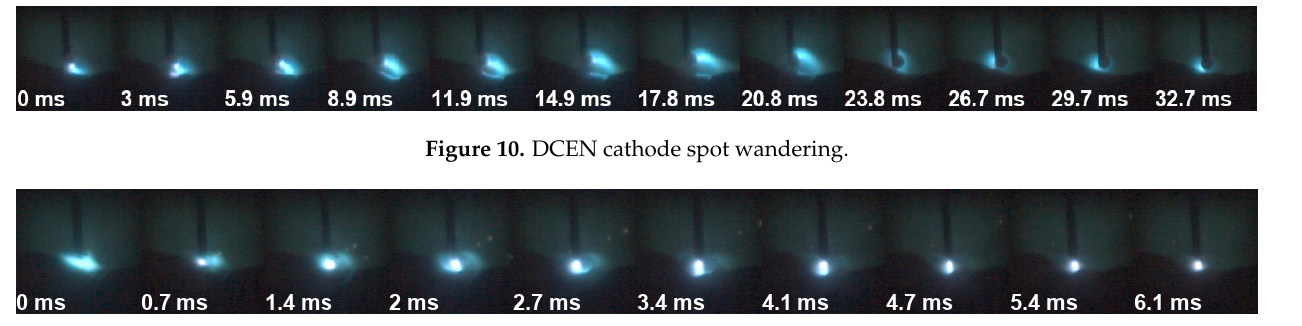
Figure 11. DCEN spattering.